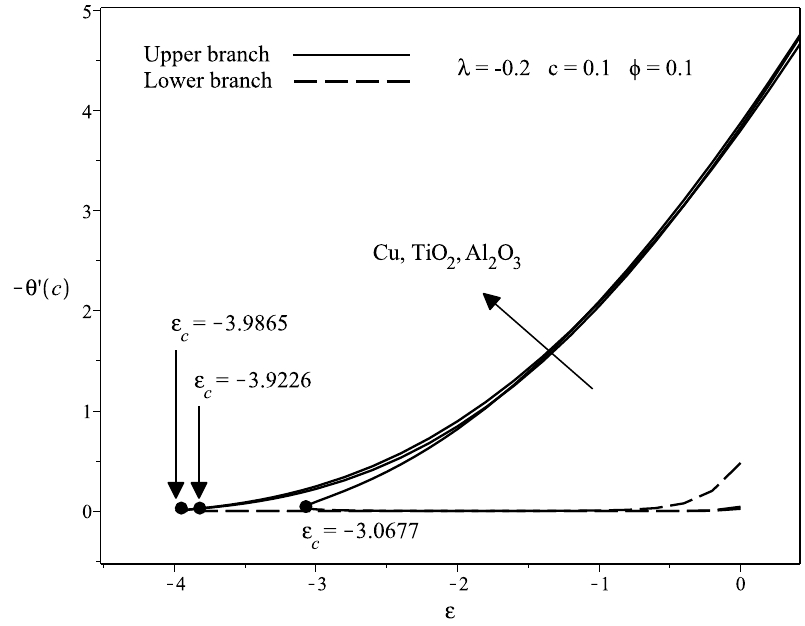
Figure 5. Effect of the velocity ratio parameter ε on the variation of local heat flux for different